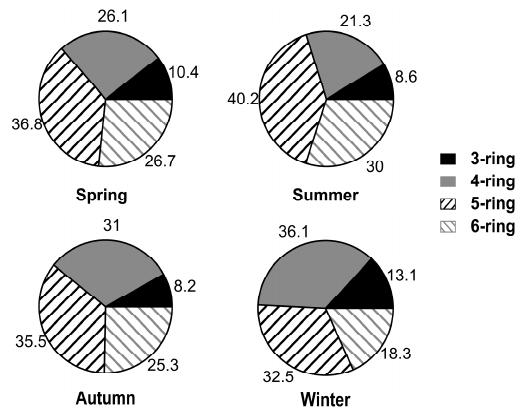
Figure 4. Seasonal variation of the proportions of 3- to 6-ring PAHs.